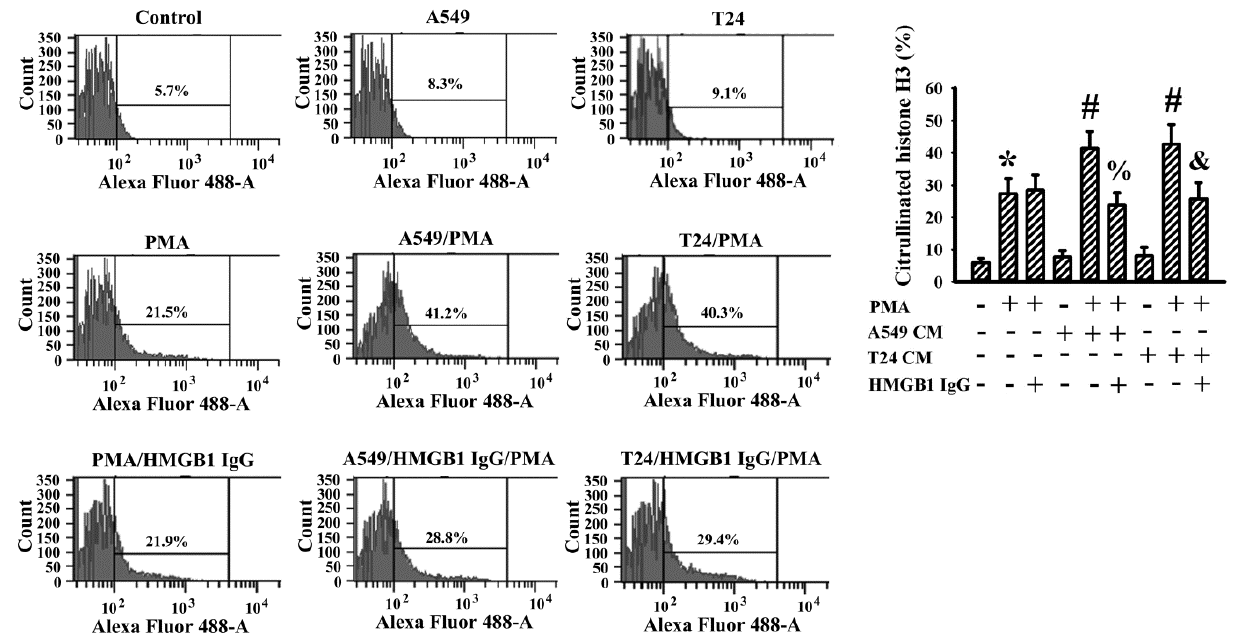
Figure 10. Conditioned medium of cancer cells promoted PMA-induced NETs in human neutrophils. Human neutrophils were treated with a vehicle (Control), PMA (100 nM) or PMA (100 nM) in combination with HMGB1-neutralizing IgG (5 μ g/mL) for 3 h. For the study of cancer cell effects, supernatants of subconfluent A549 and T24 cells over a period of 24 h were collected as Conditioned Medium (CM). Human neutrophils were treated with A549 CM (with an equal volume of fresh medium), T24 CM (with an equal volume of fresh medium), or in combinations as indicated for 3 h. For the neutralization study, A549 CM and T24 CM were incubated with HMGB1-neutralizing IgG (5 μ g/mL) for 15 min prior to being added to the neutrophils. The treated neutrophils were subjected to flowcytometric analysis for the measurement of citrullinated histone H3 positivity with an indicated primary antibody and an Alexa Fluor 488-labeled secondary antibody. Representative plots and quantitative data are shown. * p < 0.05 vs. untreated group, # p < 0.05 vs. PMA group, % p < 0.05 vs. PMA/A549 CM group, and & p < 0.05 vs. PMA/T24 CM group, n = 3.